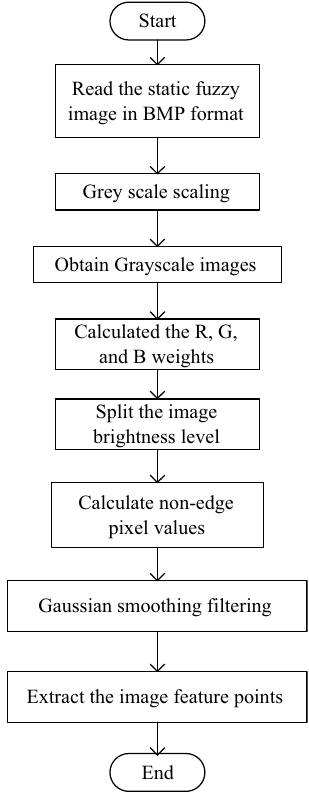
Figure 1: The fl owchart of extracting the image feature